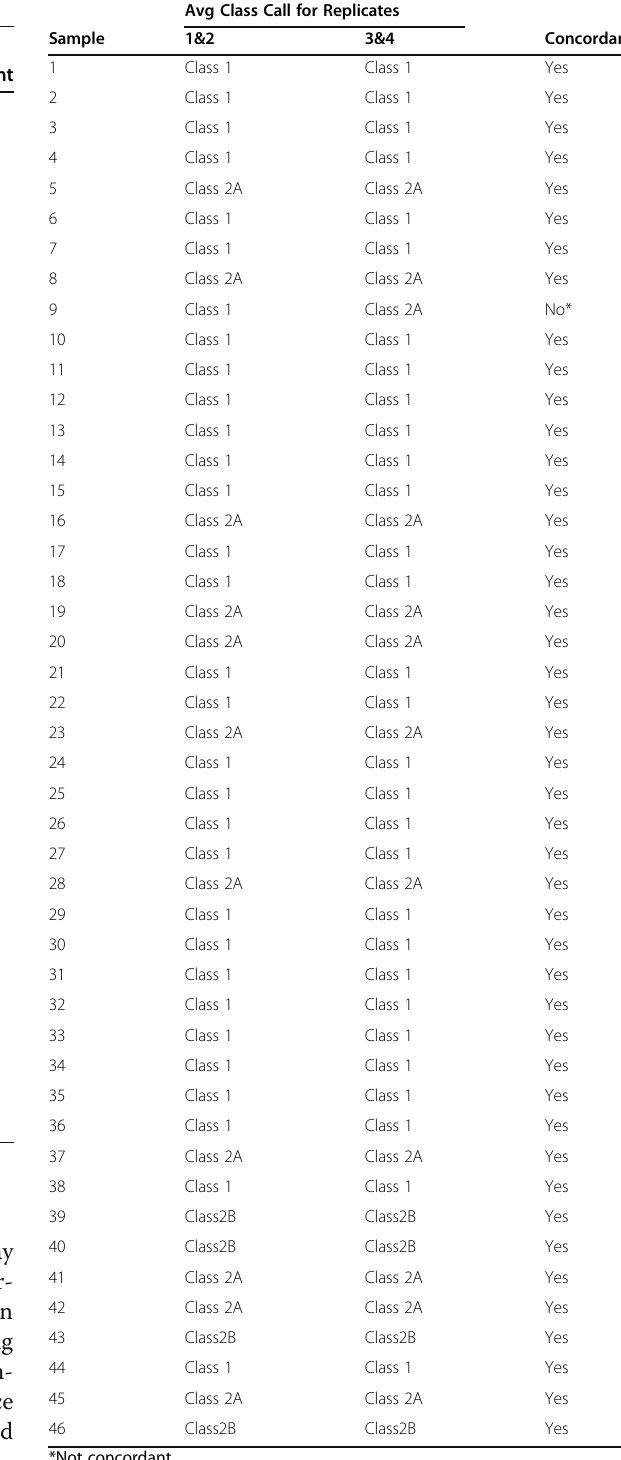
Table 2 Intra-assay summary data for replicates 1 and 2 vs 3 and 4 were used for the evaluation of Class call